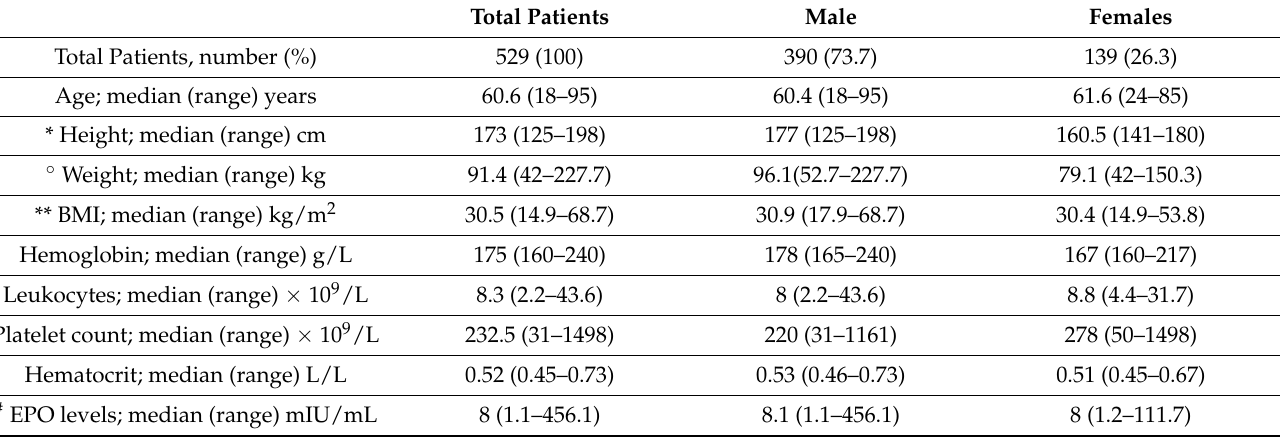
Table 1. Patients with